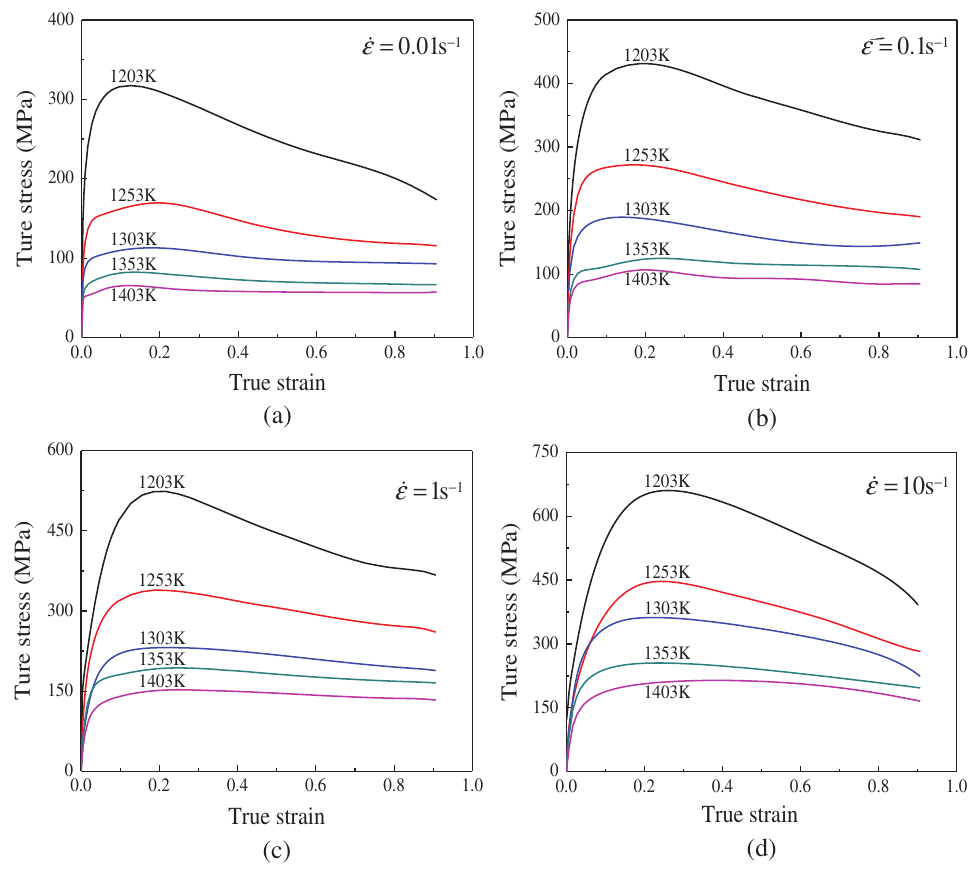
Figure 2: The stress – strain curves of 3Cr20Ni10W2 heat-resisting alloy under different temperatures with the strain rates of (a) 0.01s − 1 , (b) 0.1s − 1 , (c) 1s − 1 and (d) 10s − 1